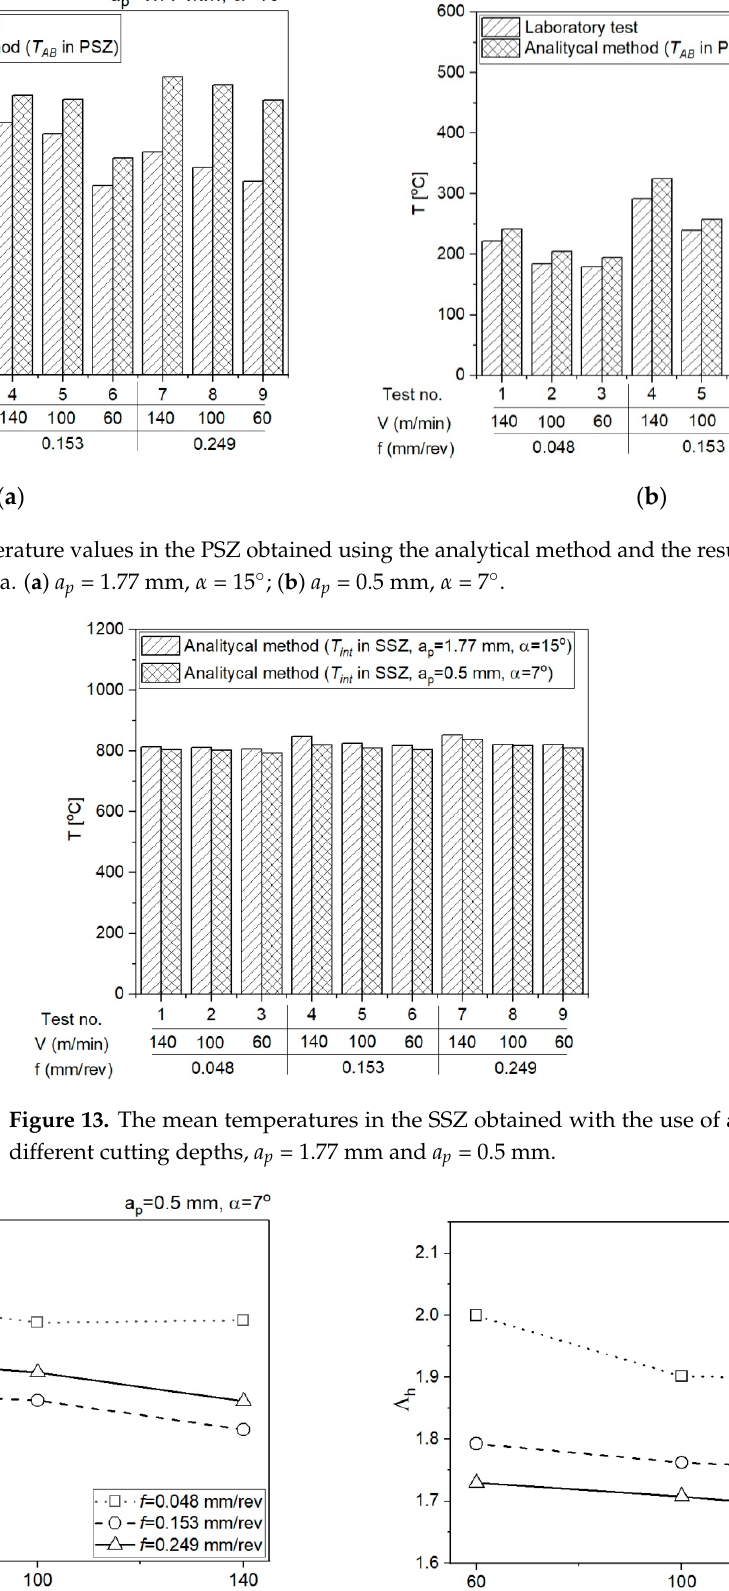
Figure 15. The friction power determined in the SSZ. The relative error for the results from the analytical method and the results from the IR measurements was determined according to the formula D = abs(T AB − T ref )/T ref , where T AB is the mean temperature in the PSZ determined analytically and T ref is the mean tem- perature in the PSZ determined experimentally with a thermovision camera. The verifica- tion of results obtained analytically in PSZ with the measurements conducted with the thermovision camera indicates the conformity of results for smaller feedrates (f = 0.048 mm/rev, f = 0.153 mm/rev). The maximum relative error between the results from calcu- lations and the results from measurements with the thermovision camera is 13%. For feedrate f = 0.249 mm/rev, the error is greater and equal to 30% (Figure 16). The greater difference between the calculated temperature and the measured temperature results probably from the larger cross-section of the cutting zone and the larger chip heat capac- ity.